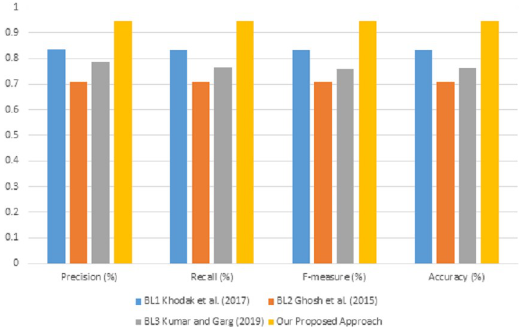
Fig 5. Results comparison of our proposed framework with the baseline